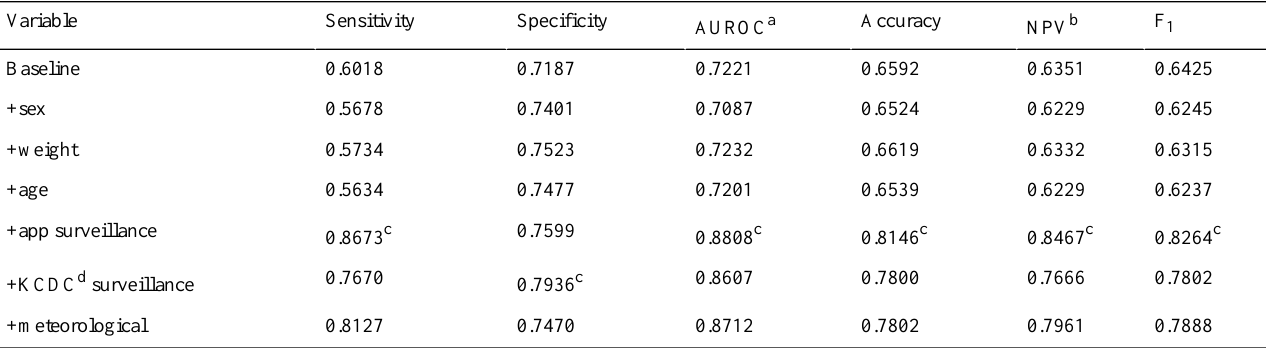
Table 4. Effect of each variable on the analysis. The baseline included body temperature, antipyretic drug, and antibiotic drug data. “+<variable>” means that the variable was added to the baseline for the analysis and then removed for the next analysis (noncumulative addition).